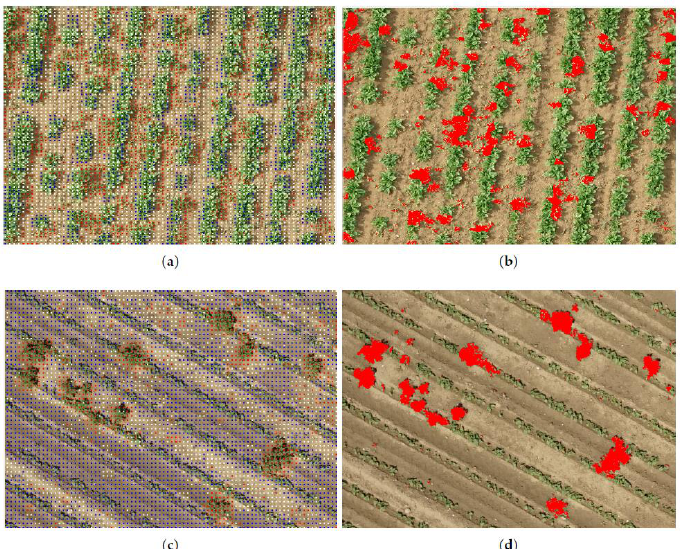
Figure 12. Examples of unmanned aerial vehicle (UAV) picture categorization using unsupervised data models in spinach, and bean fields. ( a ) Sample of a spinach field acquired using a sliding window, without a crop line or any background details; ( b ) Sample from spinach field acquired after applying crop line and background information; ( c ) Sample of a been field acquired using a sliding window, without a crop line or any background details; ( d ) Sample from been field acquired after applying crop line and background information. Crops are represented in blue, weeds in red, and uncertain decisions in white [35].